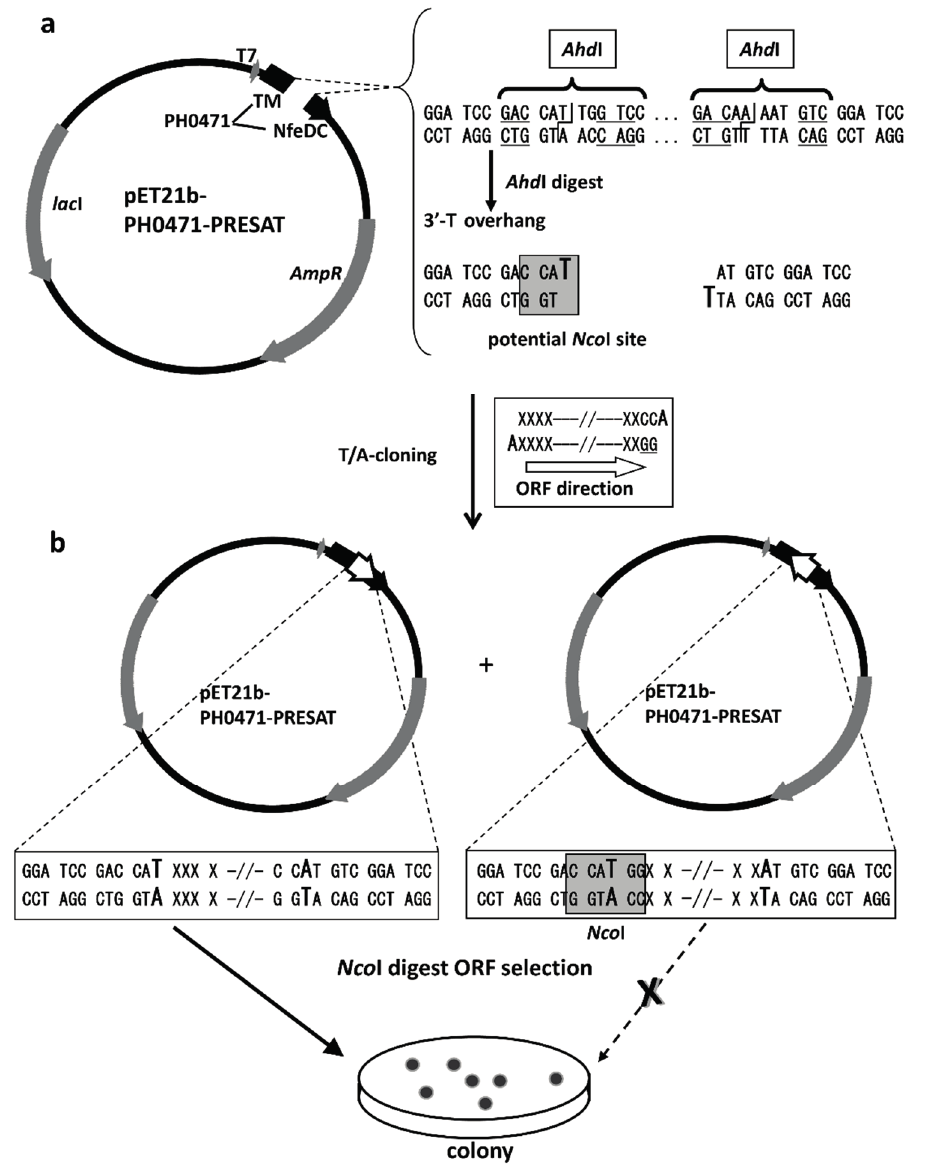
Figure 2. Construction of the PH0471-based PRESAT vector. ( a ) Vector map of pET21b-PH0471-PRESAT after Ahd I digestion; ( b ) Schematic of the unidirectional